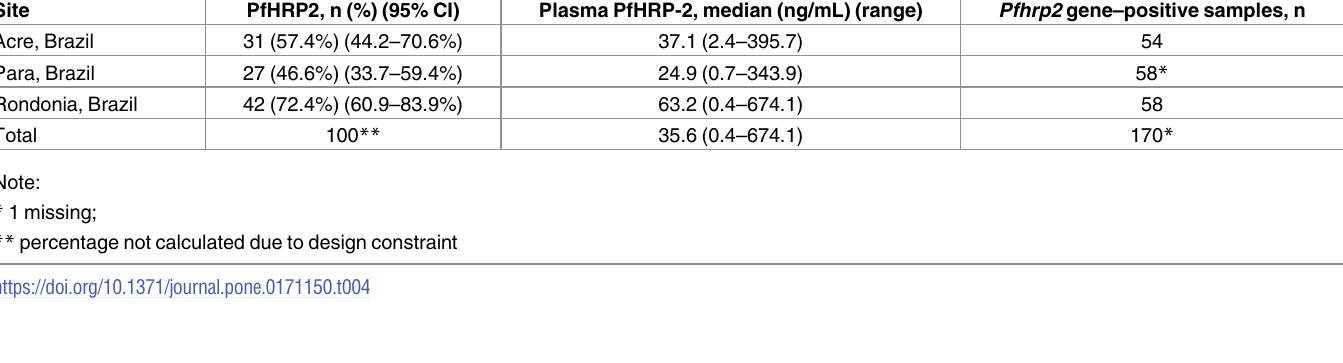
Table 4. Number of samples positive for P . falciparum histidine-rich protein 2 (PfHRP2) protein and protein level among for pfhrp2 gene positive specimens, Brazil (170 samples). Site Pfhrp2 gene–positive samples,